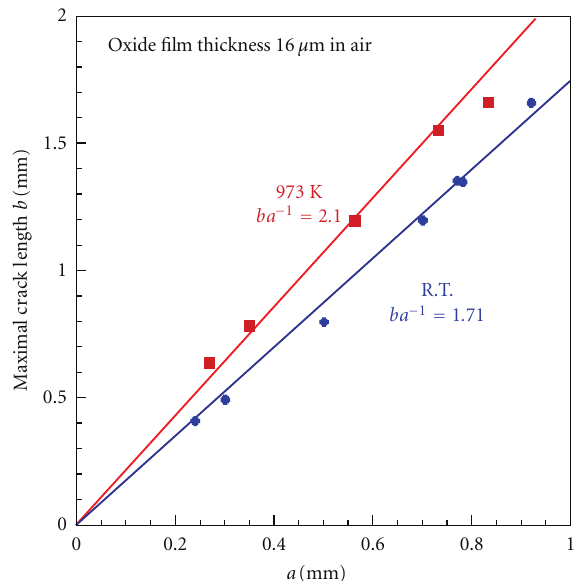
Figure 8: Relations between diameter of indentation a and maximal crack length b by the impact at 973 K and R.T., for nickel oxide films formed at 973 K. Figure 9: Compressive strain distribution against relative distance